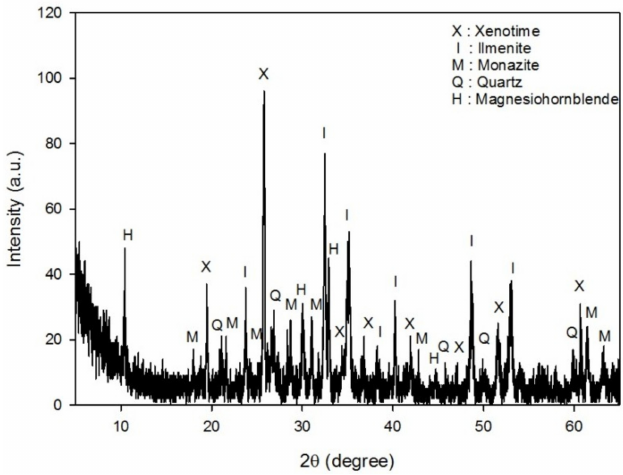
Figure 4. X-ray diffraction (XRD) pattern of 1.0 T magnetic product.